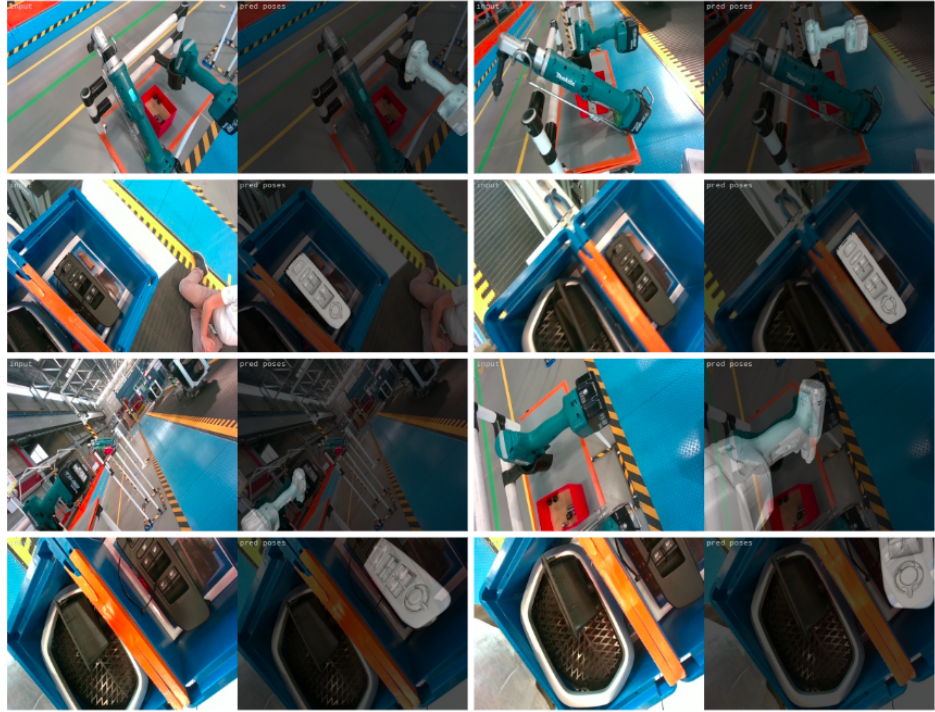
Figure 20. Examples of predictions on real test images. The first rows present correct object pose predictions, while the last two show incorrect